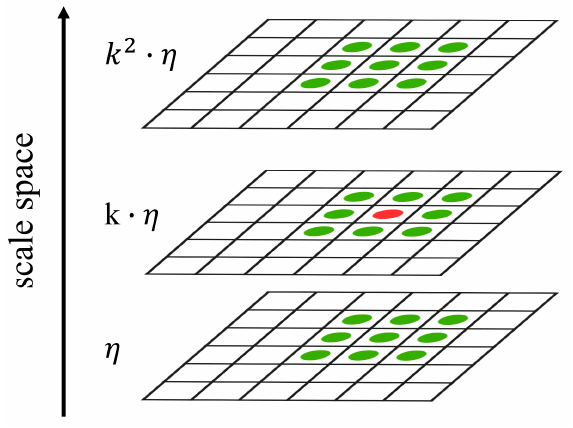
Figure 3. The extraction of extrema from a DOG. A pixel (red) is compared with eight neighbors in the current DOG and nine neighbors (all pixels in green) in the DOG above and below, respectively.